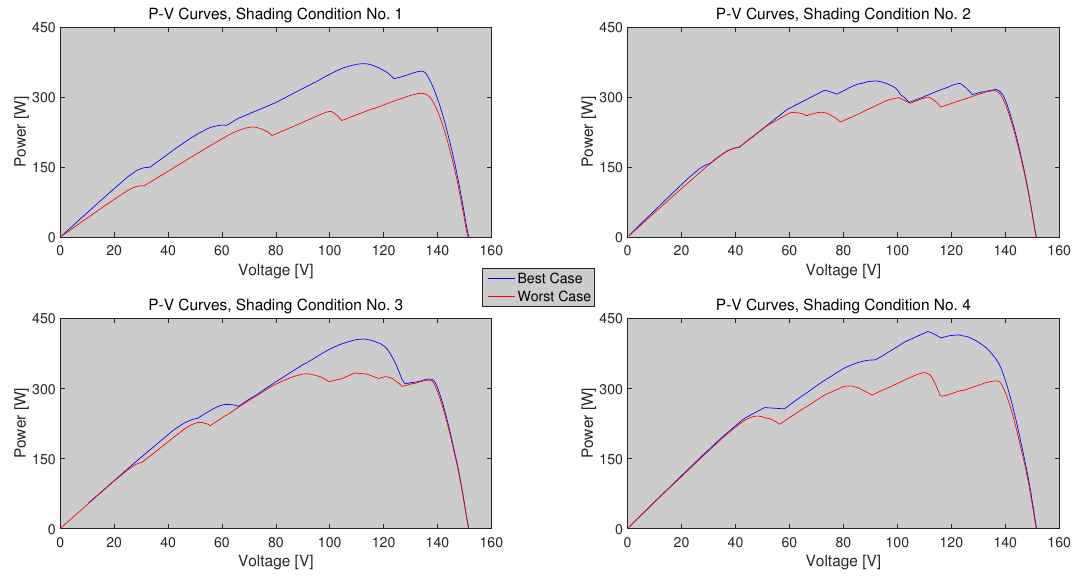
Figure 11. Array P-V curves for best and worst configurations for each shading